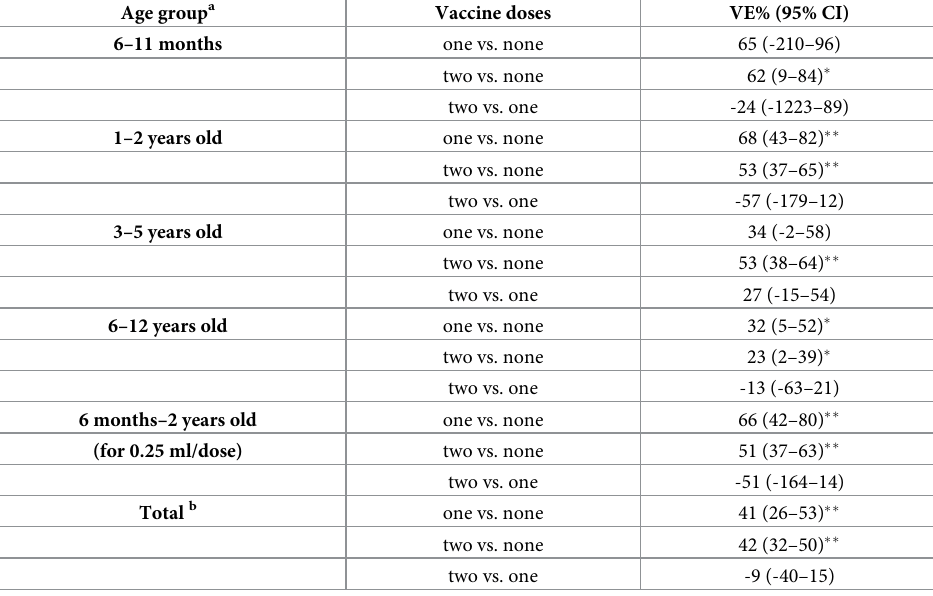
Table 6. Adjusted vaccine effectiveness (VE) of quadrivalent inactivated influenza vaccine by vaccine dose for pre- venting influenza illness among children in the 2018/19 season. Adjusted vaccine effectiveness (VE) against influ- enza A by vaccine